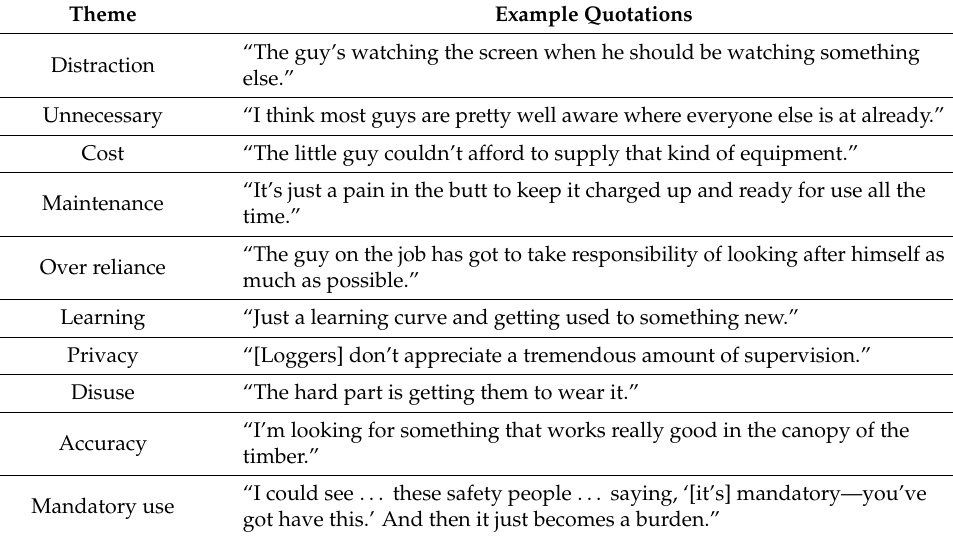
Table 9. Salient interview themes related to potential limitations of real-time location-sharing